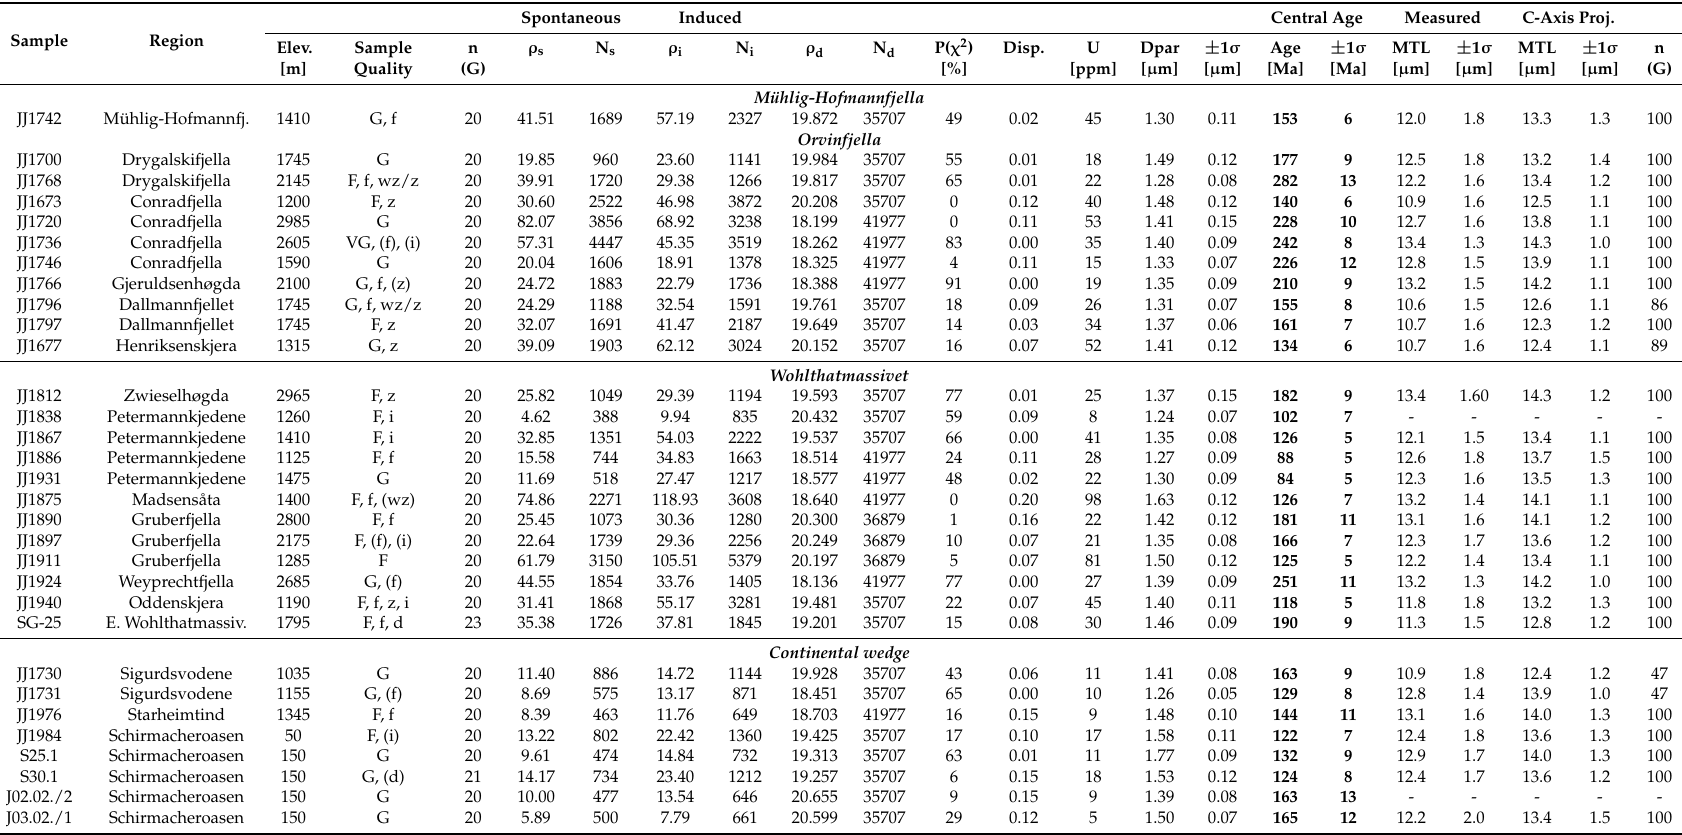
Table footnote: n(G): number of dated grains; n(TL): number of measured track lengths; N s,i,d : number of spontaneous (N s ) and induced (N i ) tracks and number of tracks counted on dosimeter glass IRMM-540R (N d ); ρ s,i,d : track densities (1 × 10 5 tracks cm − 2 ) of spontaneous ( ρ s ) and induced ( ρ i ) tracks and on dosimeter glass IRMM-540R ( ρ d ); P( χ 2 ): p-value of the chi-square homogeneity test [98]; Disp.: dispersion; U: uranium concentration; Dpar: etch pit diameter; MTL: mean track length. Sample quality: VG: very good; G: good; F: